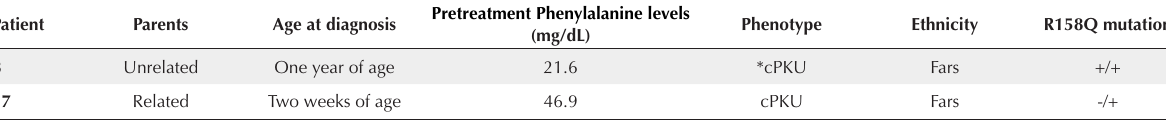
Table 2 . the characteristics of patients with R158Q mutation in the present study Patient Parents Age at